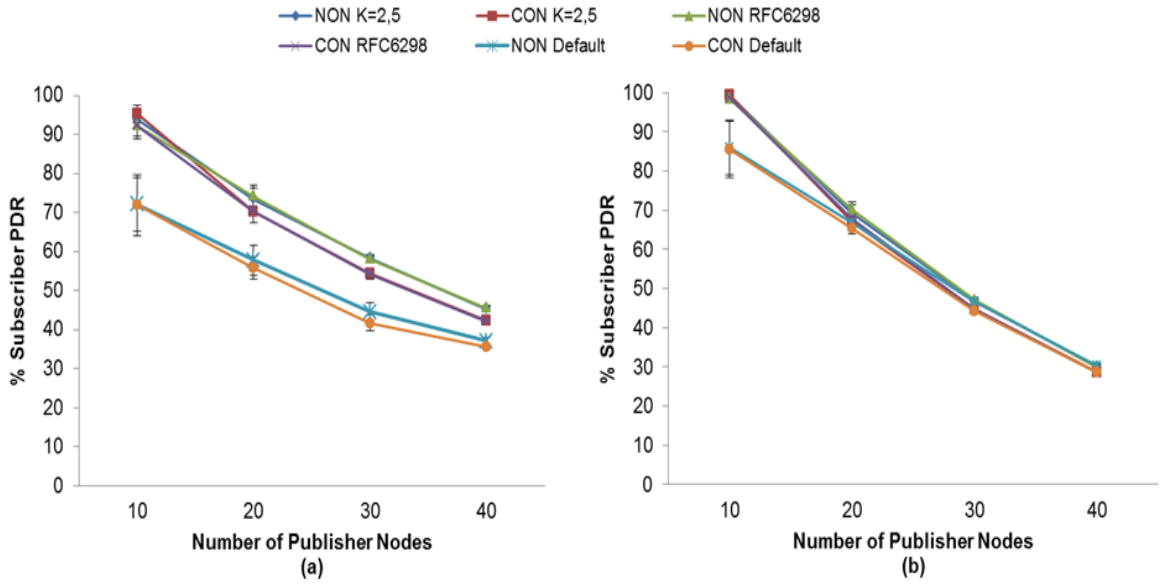
Figure 21. PDR comparisons between the RTO method of CoAP calculation and our proposal without ( a ) and with ( b ) MAC